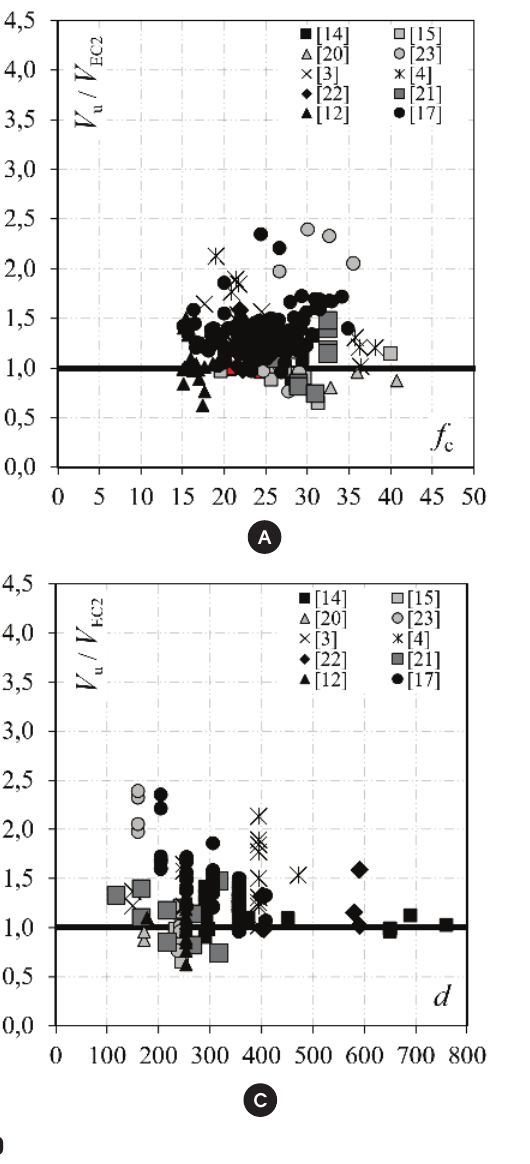
Comparison between experimental results and recommendations of Eurocode 2